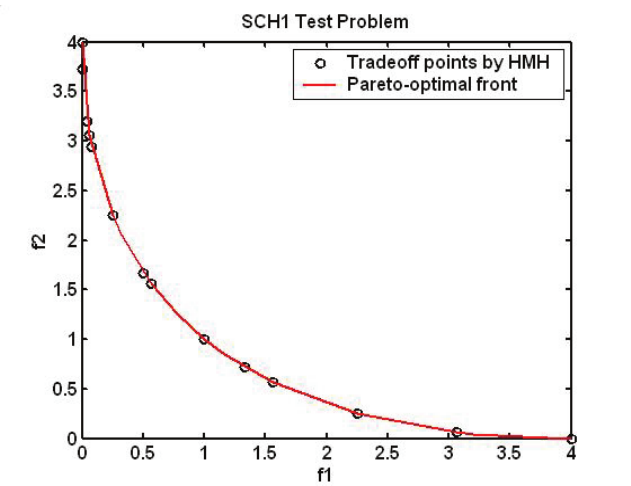
Fig. 4. Tradeoff points with HMH technique on